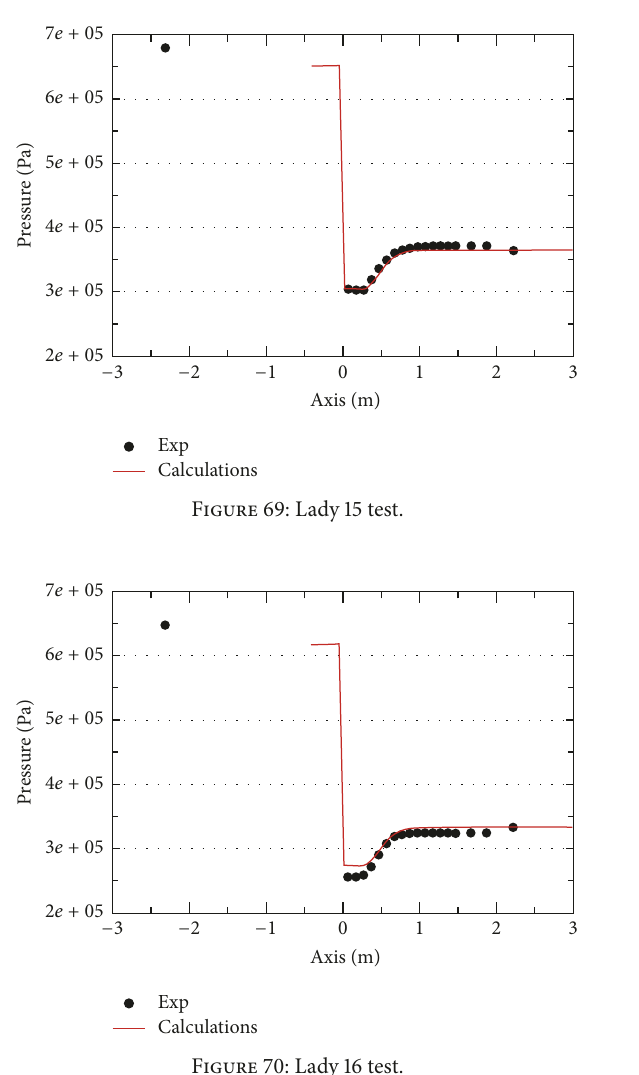
Figure 70: Lady 16 test.